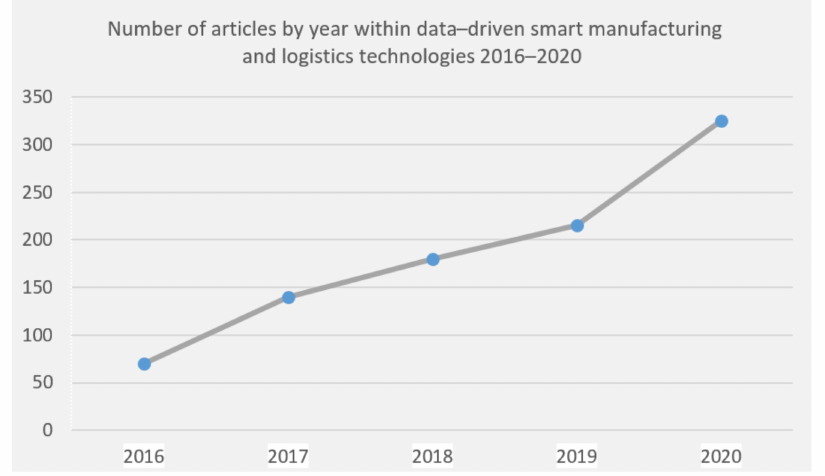
Figure 1. Number of articles by year within data-driven smart manufacturing and logistics